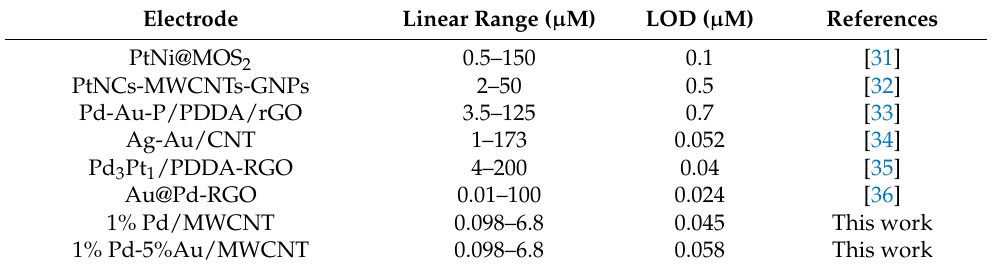
Table 1. Comparison of different electrodes for the determination of dopamine (DA).